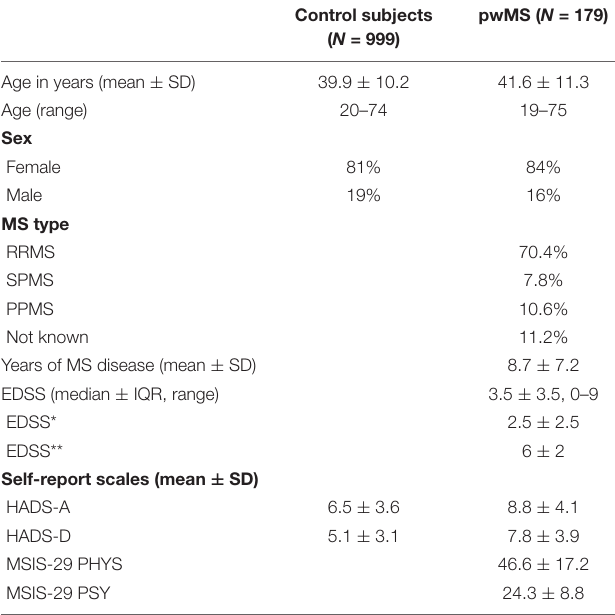
TABLE 1 | Characteristics of study participants.